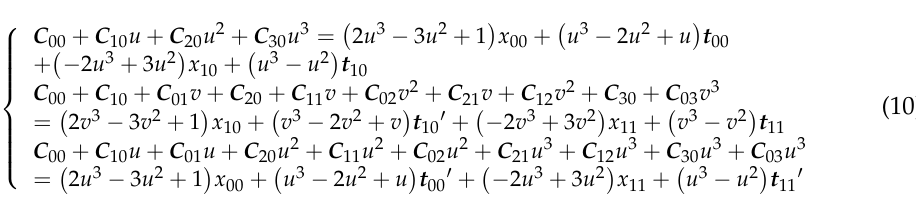
Figure 8. Hermite surfaces for different values of a . Equations (8) and (9) are combined to obtain Equation